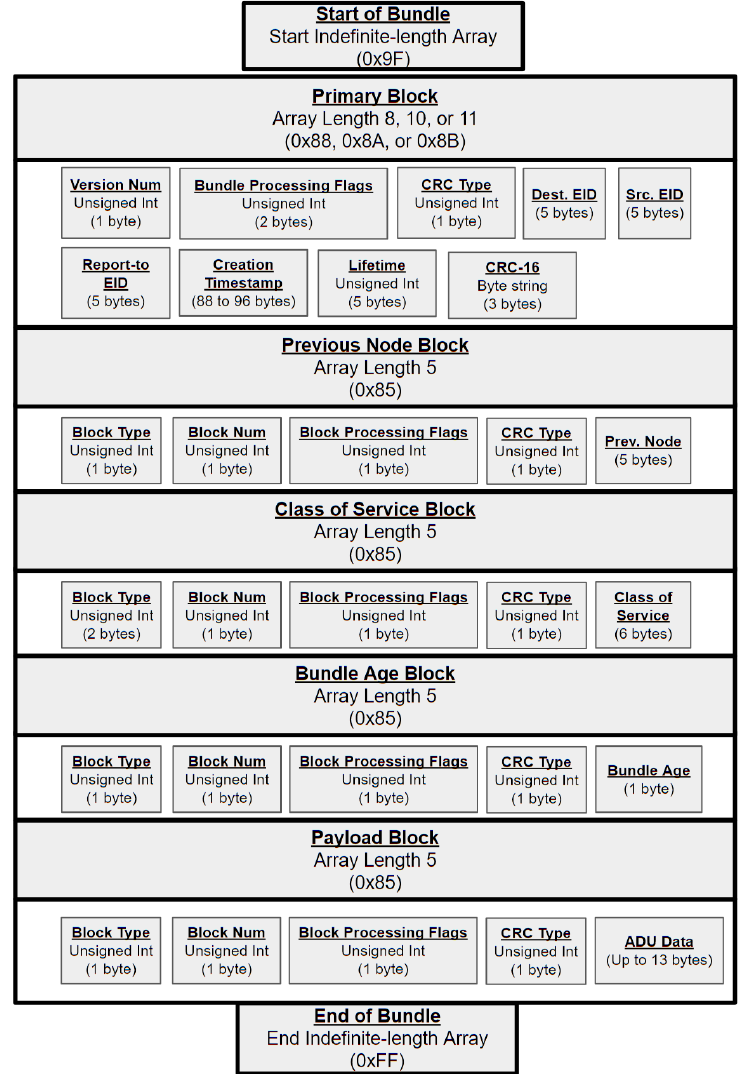
Figure 10. Expected format for incoming BPv7 bundles. Note that in the primary block, the creation timestamp can be between 88 to 96 bytes. A Previous Node Block, Experimental Class of Service Block, and Bundle Age Block are the only extension blocks expected, in this specific order. Additionally, currently only payloads up to 13 bytes are expected. There is undefined behavior for any bundles sent to the bundle translator that do not match this